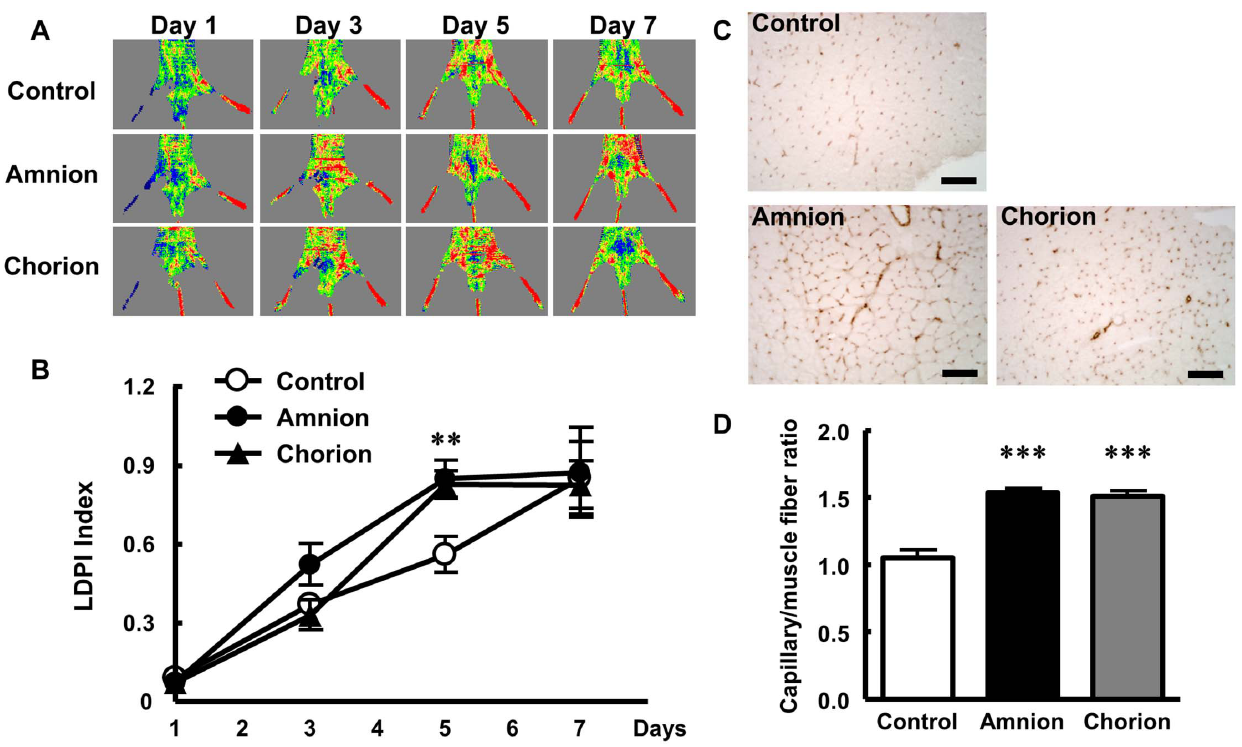
Figure 3. Angiogenic potential of amnion and chorion MSCs against hindlimb ischemia. (A) Representative images of serial hindlimb blood perfusion. Blood perfusion of ischemic hindlimb increased in the amnion and chorion MSC groups at day 5. (B) Quantitative analysis of hindlimb blood perfusion with the LDPI index, the ratio of ischemic to non-ischemic hindlimb blood perfusion. (C) Representative photographs of immunohistochemistry with anti-CD31 antibody. Scale bars=100 m m. (D) Quantitative analysis of capillary density in ischemic hindlimb muscle at day 5 among the control, amnion, and chorion MSC groups. Capillary density is shown as the capillary-to-muscle-fiber ratio. Data are mean 6 SEM. **p , 0.01 and ***p , 0.001 vs.